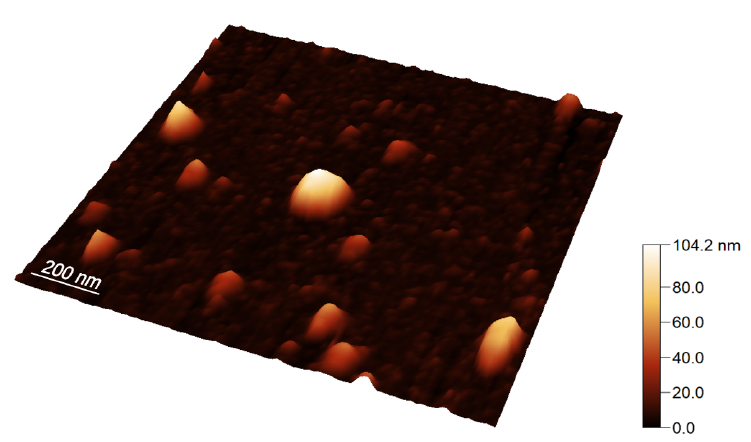
Figure 1. Three-dimensional representation of a mica fragment with EVs attached to it after 1 h from placing a drop of the sample, obtained from height imaging with AFM.